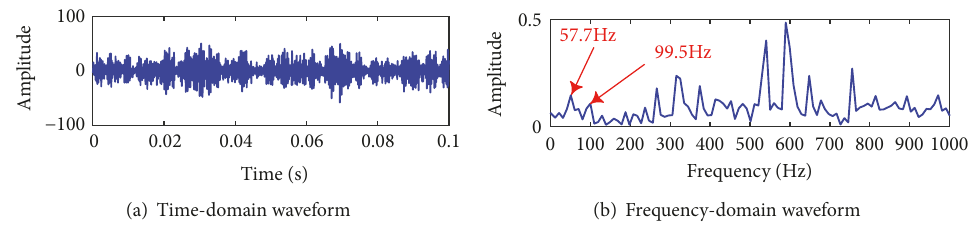
Figure 22: Time domain and spectrum analysis results of measured signals.